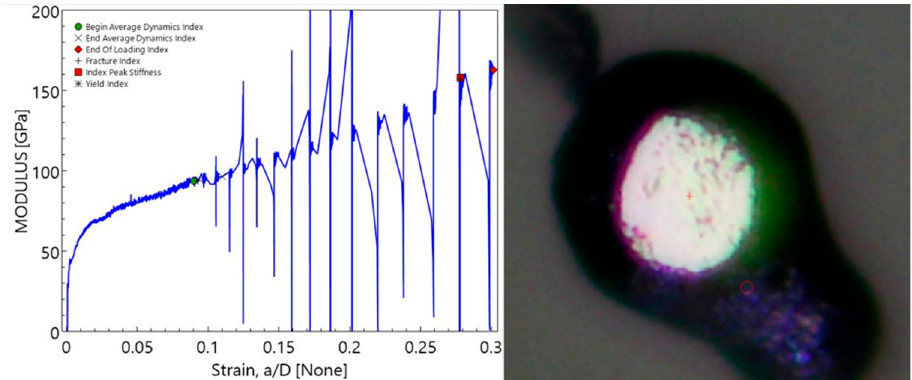
Figure 26. 𝐸 (cid:3004)(cid:3020)(cid:3014) versus strain as well as a particle post compression. Figure 26. E CSM versus strain as well as a particle post